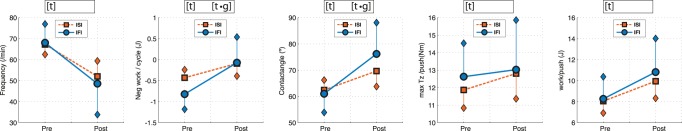
Effect of 80-minute practice on the propulsion technique (mean and standard-error of multi-level model) for the initially slow learners and the initially fast learners between the pre- and posttest.Contact angle and negative work per cycle showed an interaction effect for the groups over time. [t] = effect of time, [g] = effect of group, [t⋅g] = interaction effect of time with group.